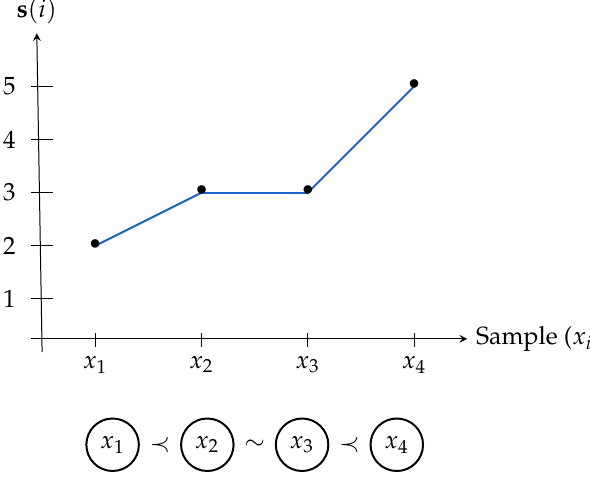
Figure 5. Example of scores describing the ranking x 1 ≺ x 2 ∼ x 3 ≺ x 4